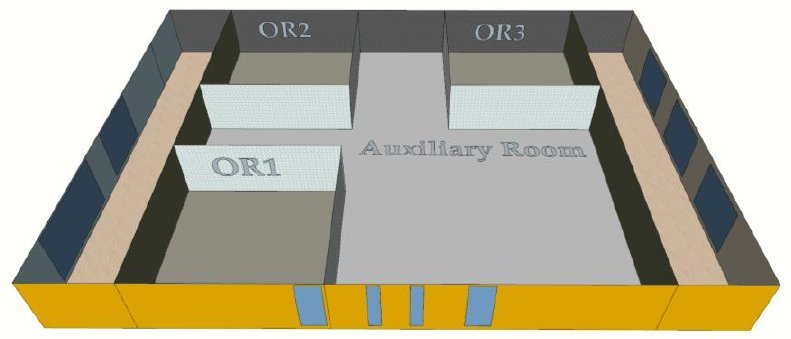
Figure 2. Geometric and constructive model generated with SketchUp and TRNBuild.